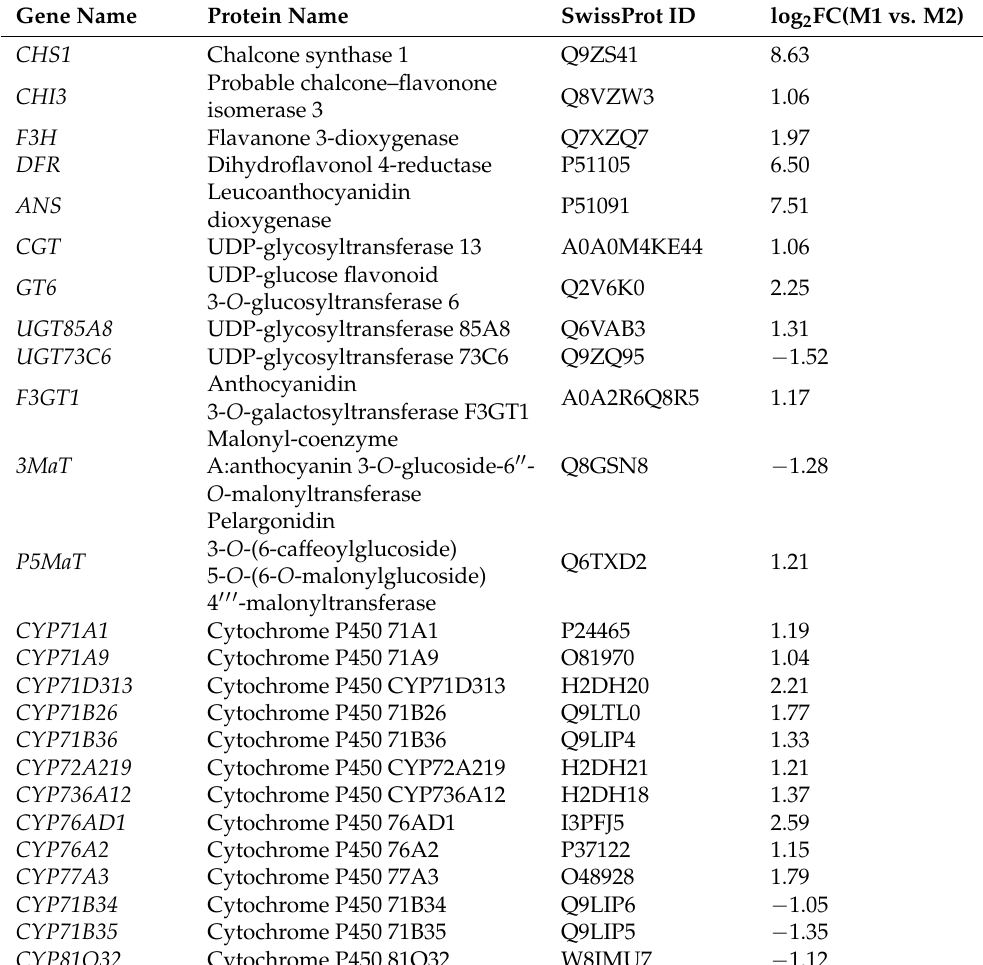
Table 3. DEGs involved in flavonoid biosynthesis and their RPKM values in M1 vs. M2.